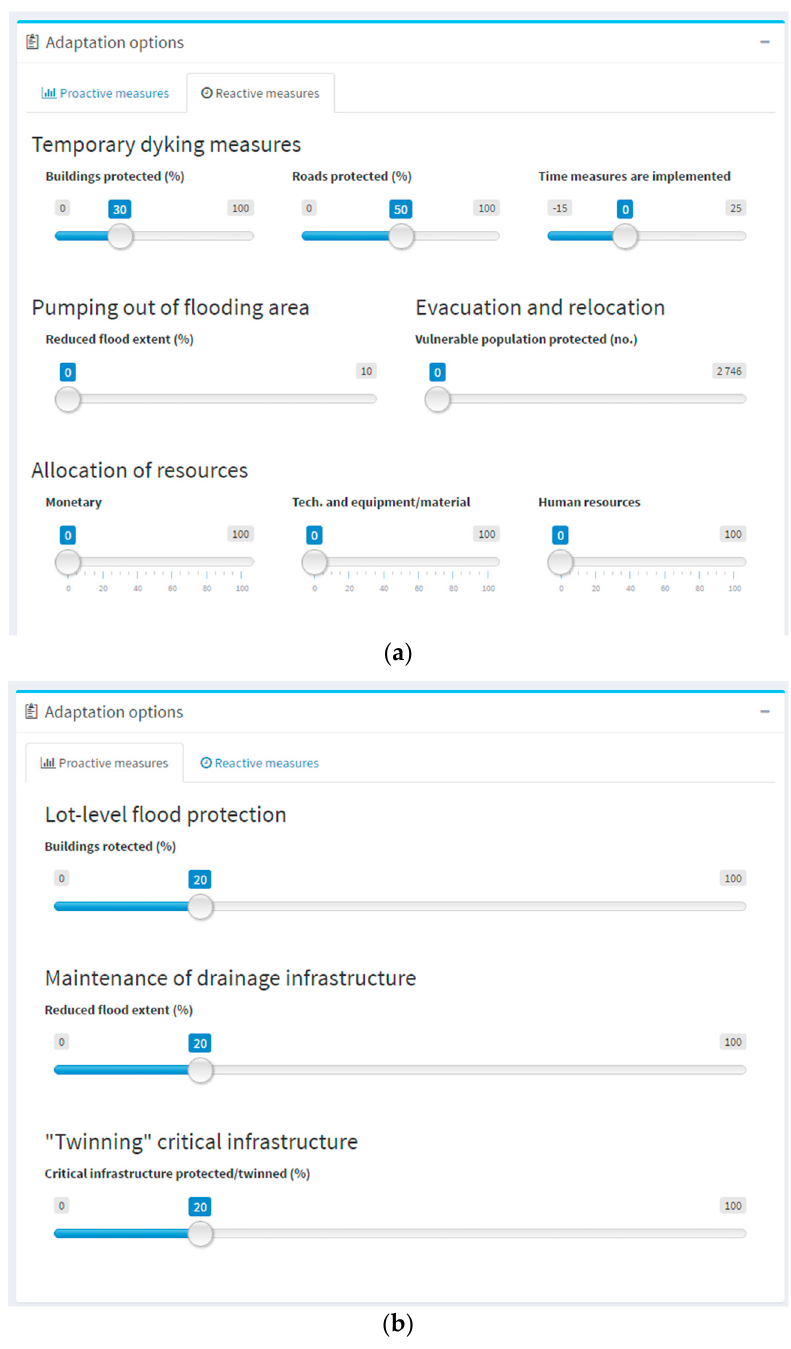
Figure 16. Interactive adaptation measures options: ( a ) reactive measures; and ( b ) pro ‐ active measures.